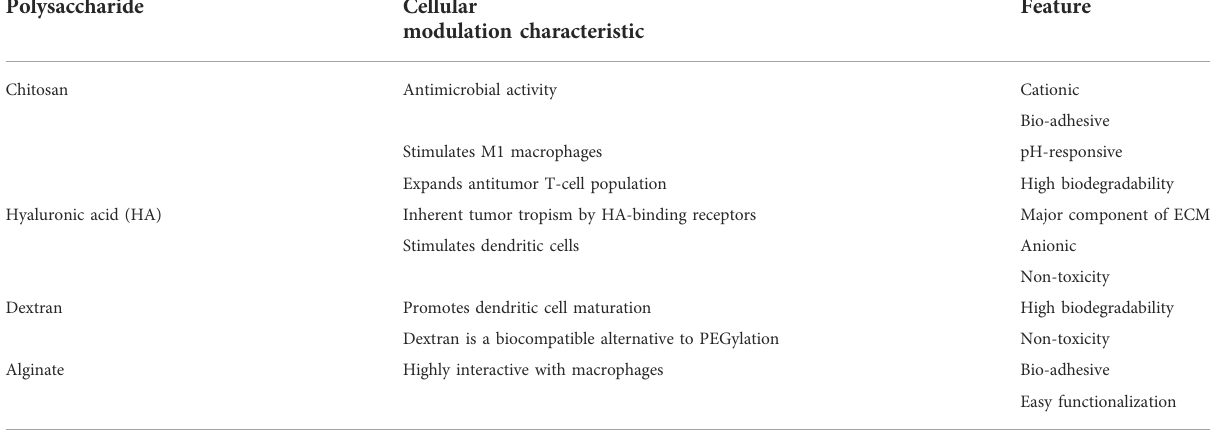
TABLE 6 Features and cellular modulation characteristics of common